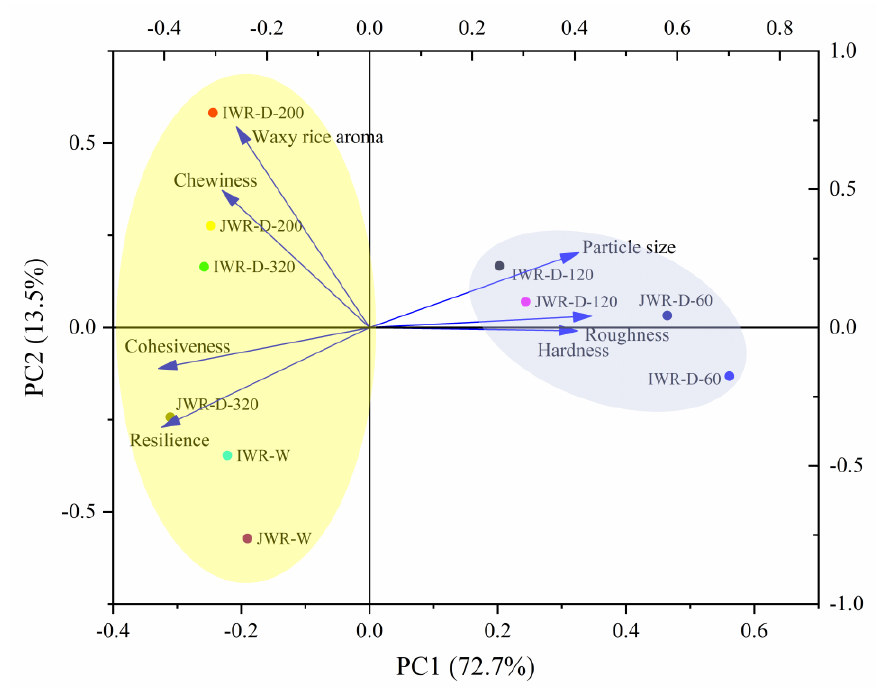
Figure 8. The PCA analysis of sensory evaluation.